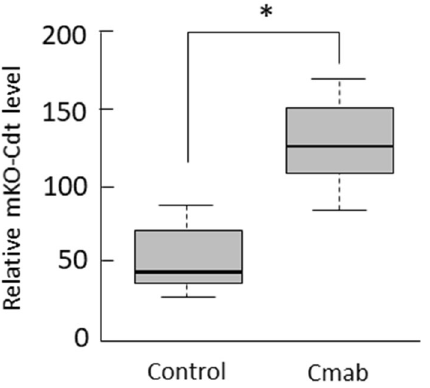
Figure 4. The mKO2-Cdt1 expression levels in fifth-day control- and cetuximab-treated SAS-Fucci cells. The mKO2-Cdt1 expression levels in individual G1 phase-arrested cell were significantly higher after treatment with cetuximab (10 µg/mL) when compared to control cells. Data are represented as box-whisker plots showing outliers, distribution intervals, 25–75% interquartile range (box), and median. * p <